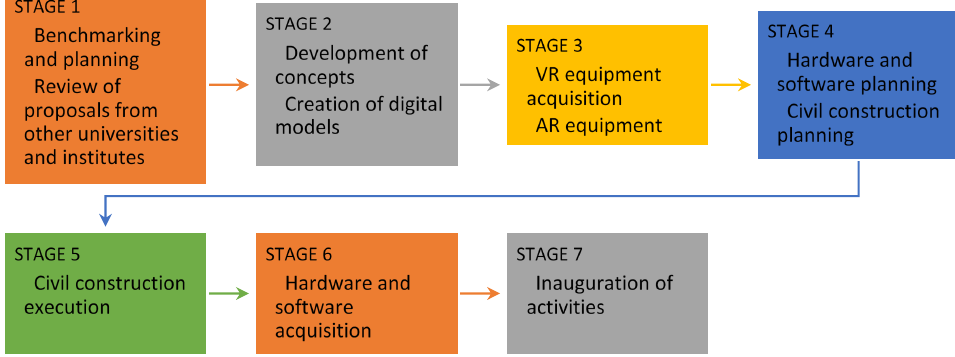
Figure 1. Planning process for the implementation of the VR/AR laboratory at